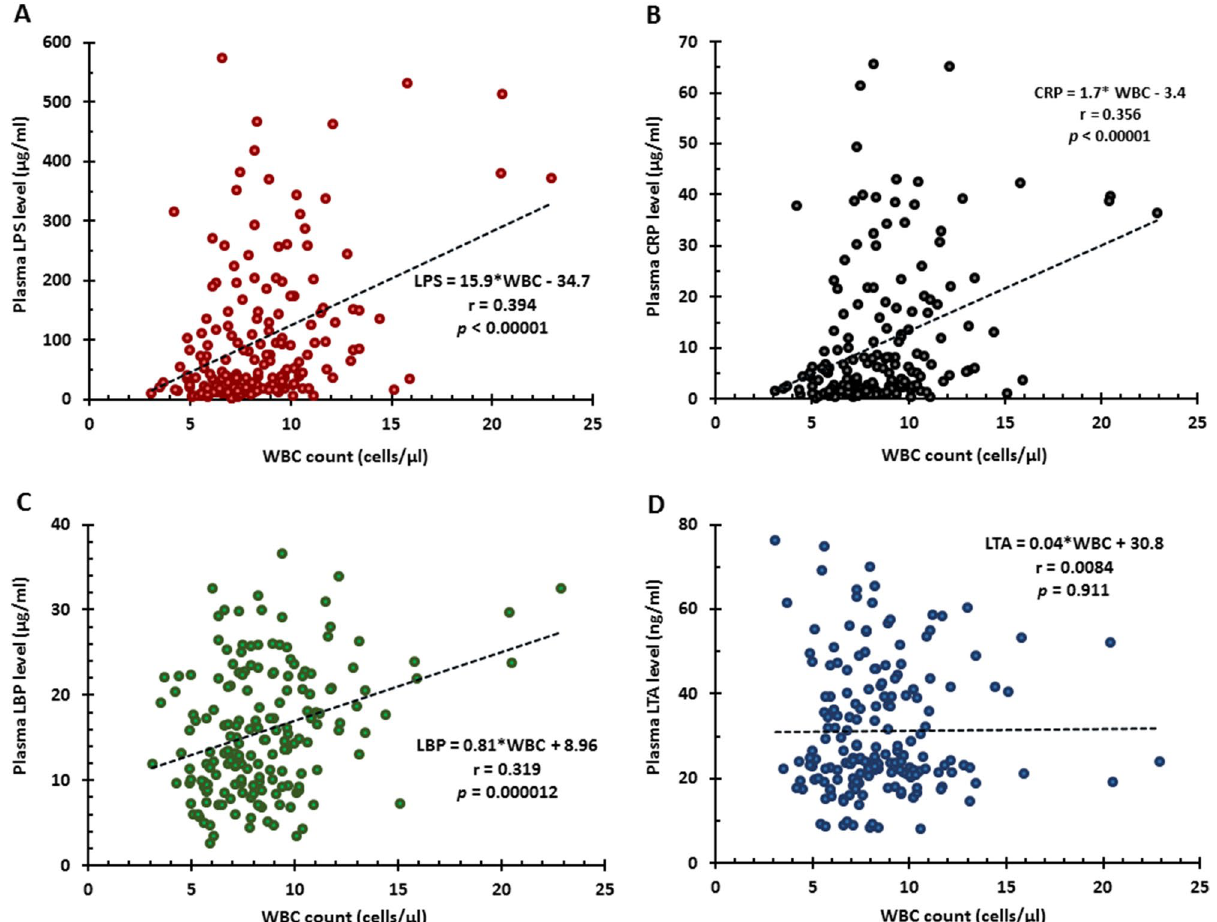
Figure 4. Pearson Correlation Analysis for WBC and levels of LPS, LBP, CRP, and LTA. WBC correlated with plasma LPS levels ( A ), CRP levels ( B ), LBP levels ( C ) but not with LTA levels ( D ). WBC white blood cell, LPS lipopolysaccharide, LBP lipopolysaccharide binding protein, CRP C-reactive protein, LTA lipoteichoic